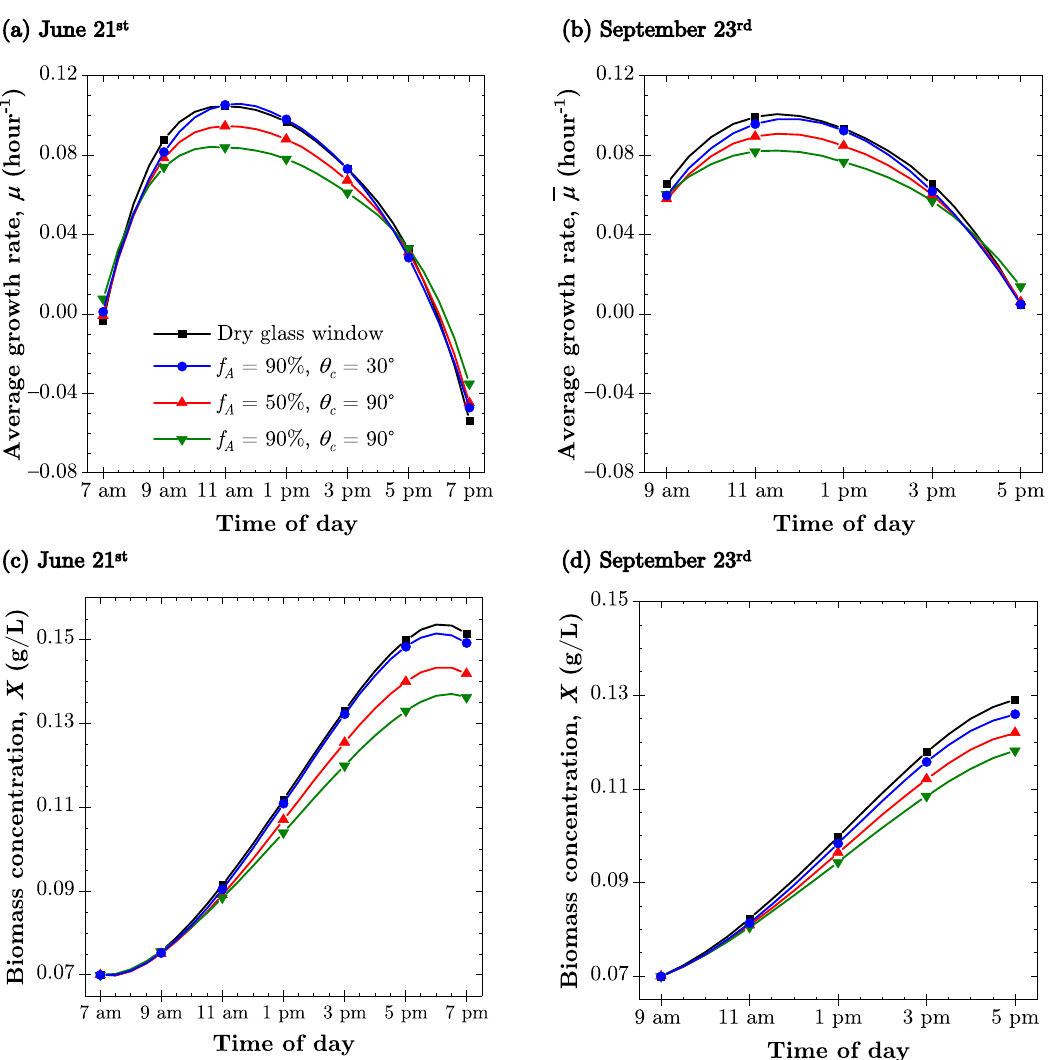
Figure 7. Average PBR growth rate ¯ µ as a function of time for various window conditions on ( a ) 21 June and ( b ) 23 September and corresponding biomass concentration X ( t ) on ( c ) 21 June and ( d ) 23